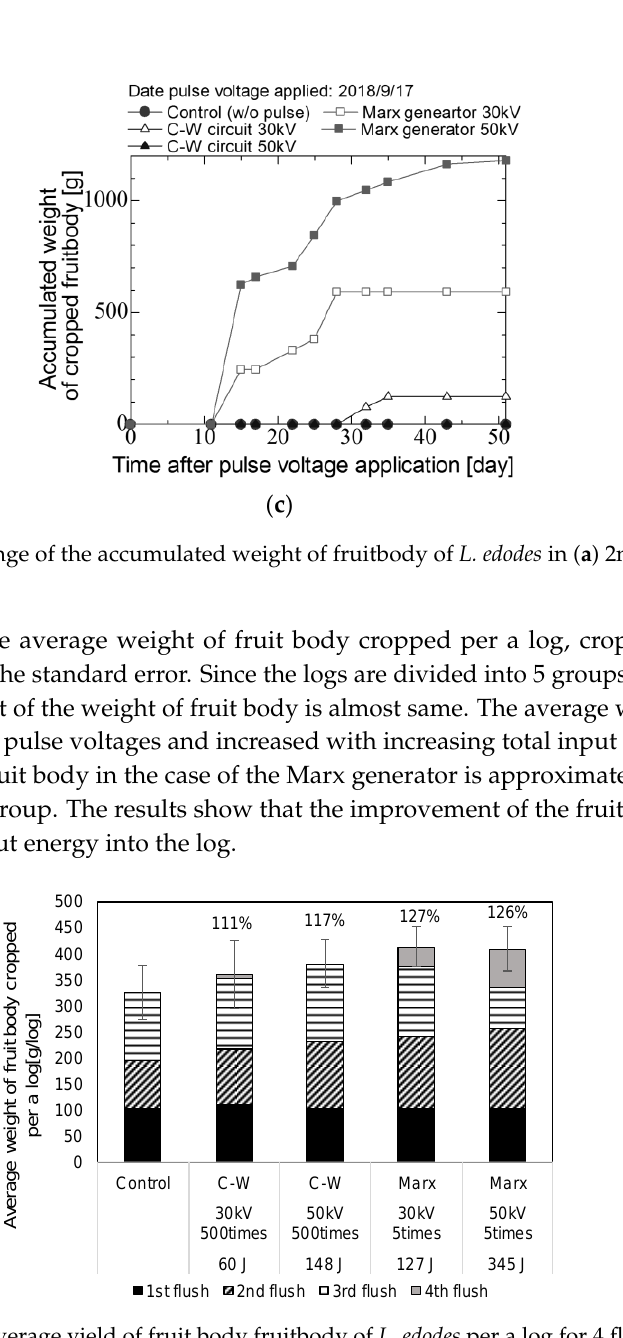
Figure 10. Average yield of fruit body fruitbody of L. edodes per a log for 4 flushes.